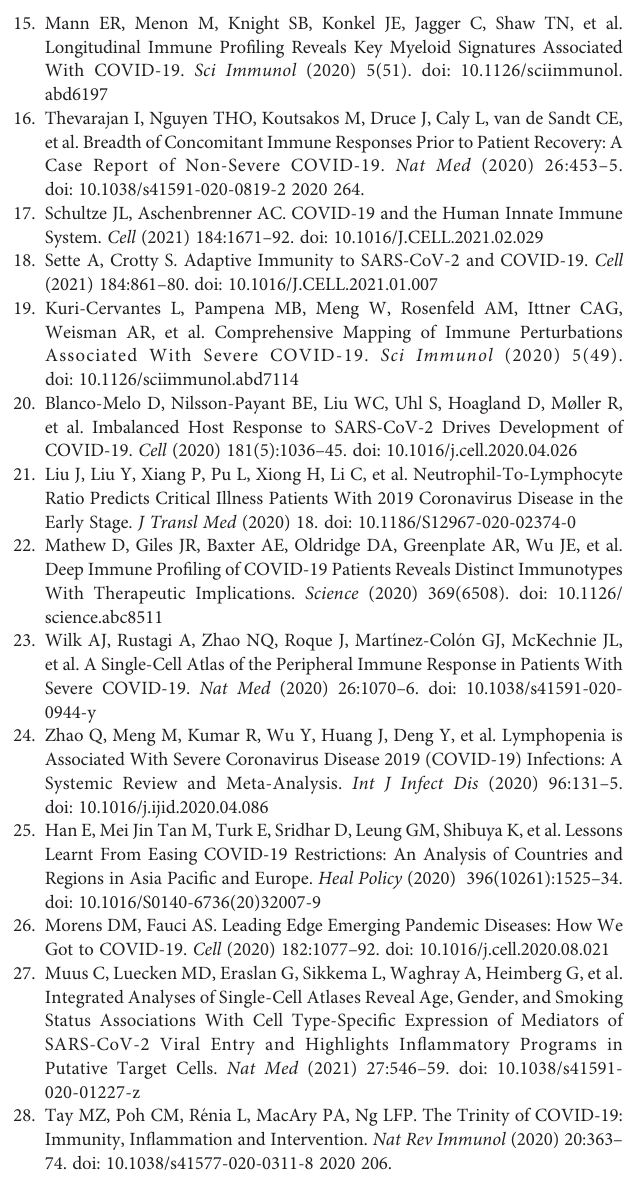
Supplementary Figure 1 | COVID-19 study diagram. (A) In this study, 29 COVID- 19 Moderate and 37 Severe COVID-19 patients, alongwith 28 convalescent patients and28HealthycontrolswererecruitedfromtheHospitalCl ı ́ nicoUniversidaddeChilefor the study of the immunological landscapeand disease evolution. Supplementary Figure 2 | Gating strategies used for fl ow cytometric analyses of immune cell subsets. (A) General analysis of main immune populations found on peripheral blood mononuclear cells of patients (B cells, CD8 and CD4 T cells, Monocytes, DCs and basophils). (B) Gating strategy used to examine CD8 and CD4 + T cell populations in peripheral blood of COVID-19 patients. (C) Gating strategy used to identify different B cell populations (Transitional, non-transitional, plasmablasts, näive, IgD - CD27 - and memory switch B cells) in fresh blood samples. (D) Characterization of granulocytes and monocytes through fl ow cytometry analysis in fresh blood samples. Supplementary Figure 3 | Granulocyte identi fi cation and Monocyte characterization from peripheral blood of COVID-19 patients. (A) Representative